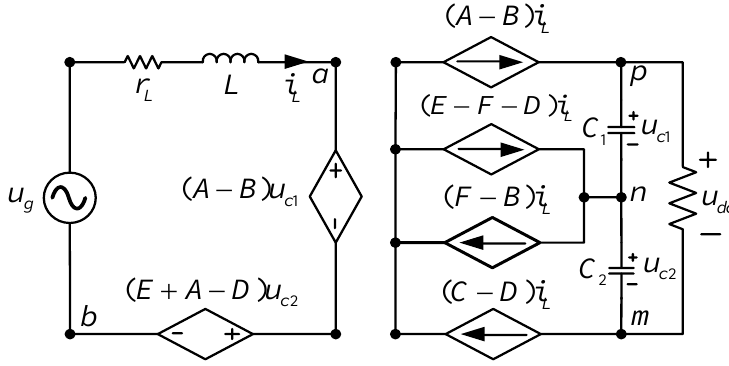
Figure 6. The equivalent circuit model of the STL-PFC topology.